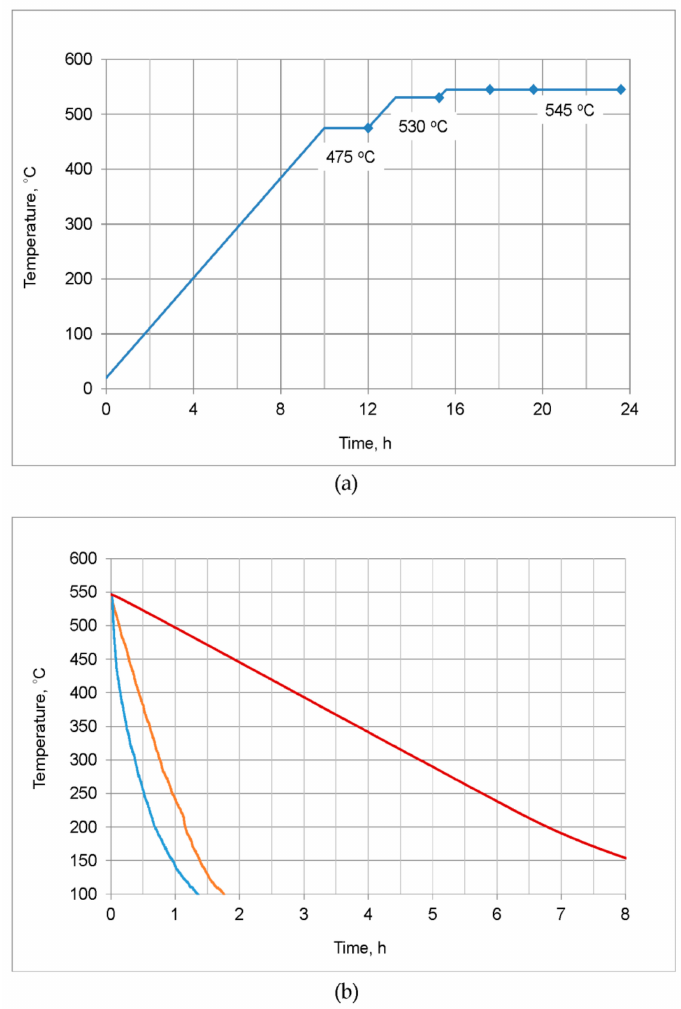
Figure 1. Laboratory homogenization experiments: ( a ) Heating and soaking conditions with marked sampling points (2nd stage of work); ( b ) cooling curves obtained after homogenization with soaking 475 ◦ C/2 h + 530 ◦ C/2 h + 545 ◦ C/8 h (3rd stage of work). The average cooling rates in the temperature range from 545 to 200 ◦ C, were about 500 (blue line), 300 (orange line), and 50 ◦ C/h (red